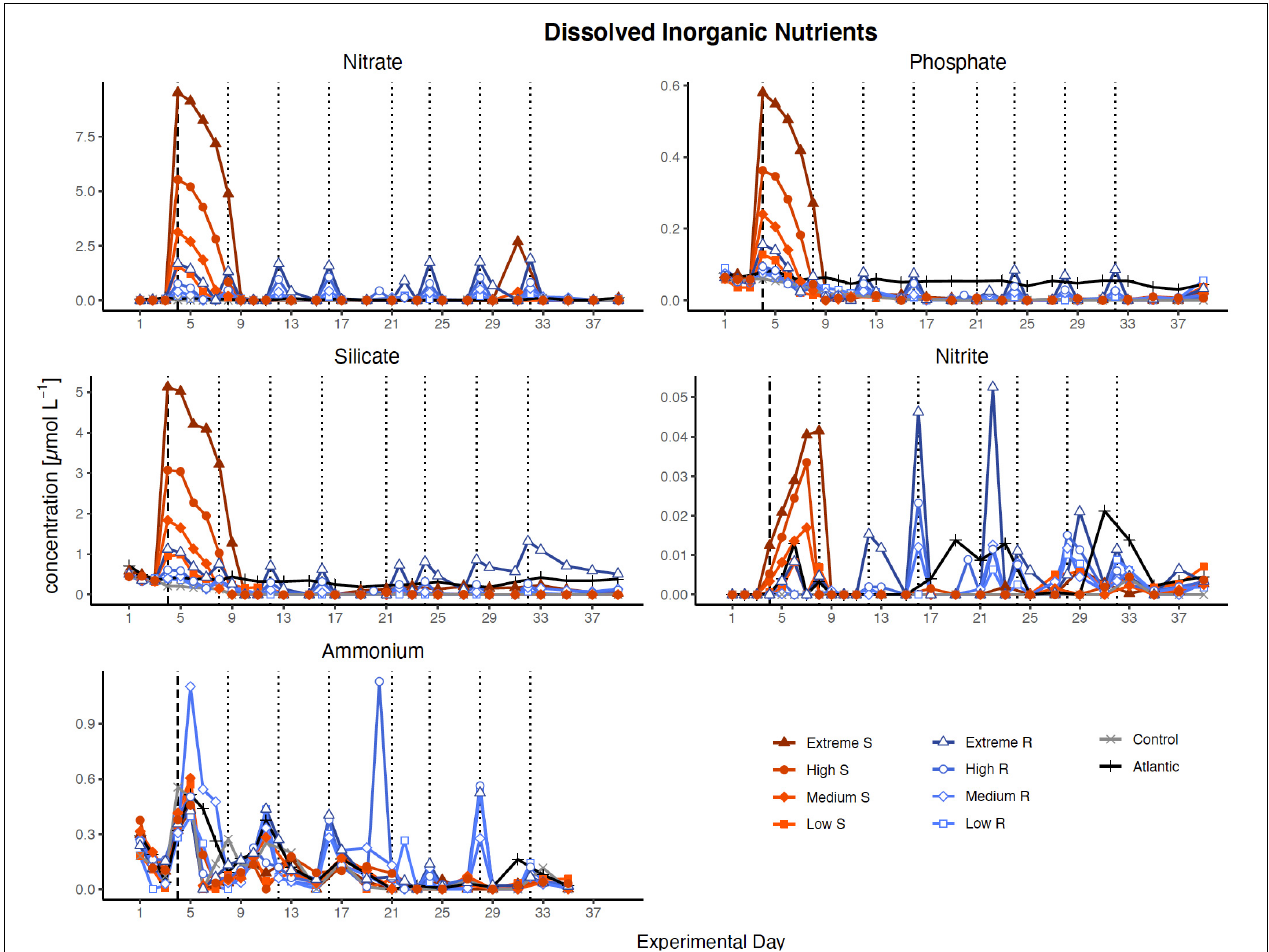
FIGURE 1 | Inorganic nutrient concentration over the course of the study. Dotted lines represent DW additions, dashed line marks the single DW addition to singular treatments. S, singular; R, recurring treatment. Atlantic refers to samples taken from the water surrounding the mesocosm field.